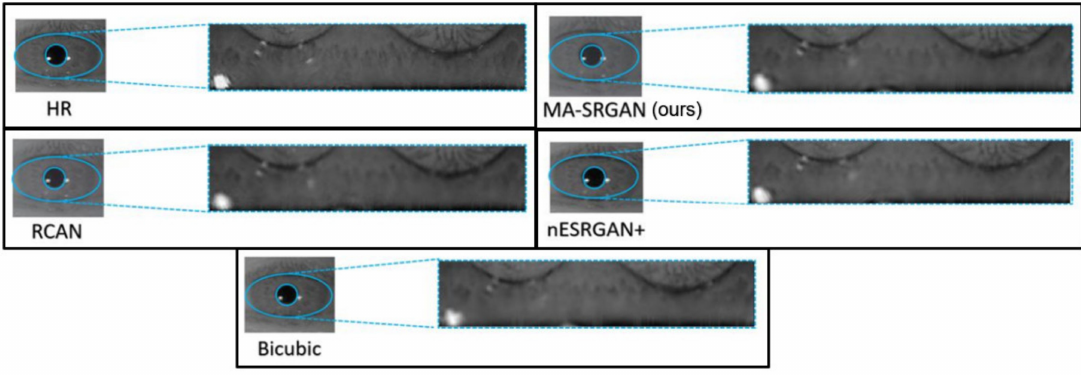
Figure 18. Visual results with Bicubic degradation ( × 4) on “Rcls489_7” from the CASIA dataset.